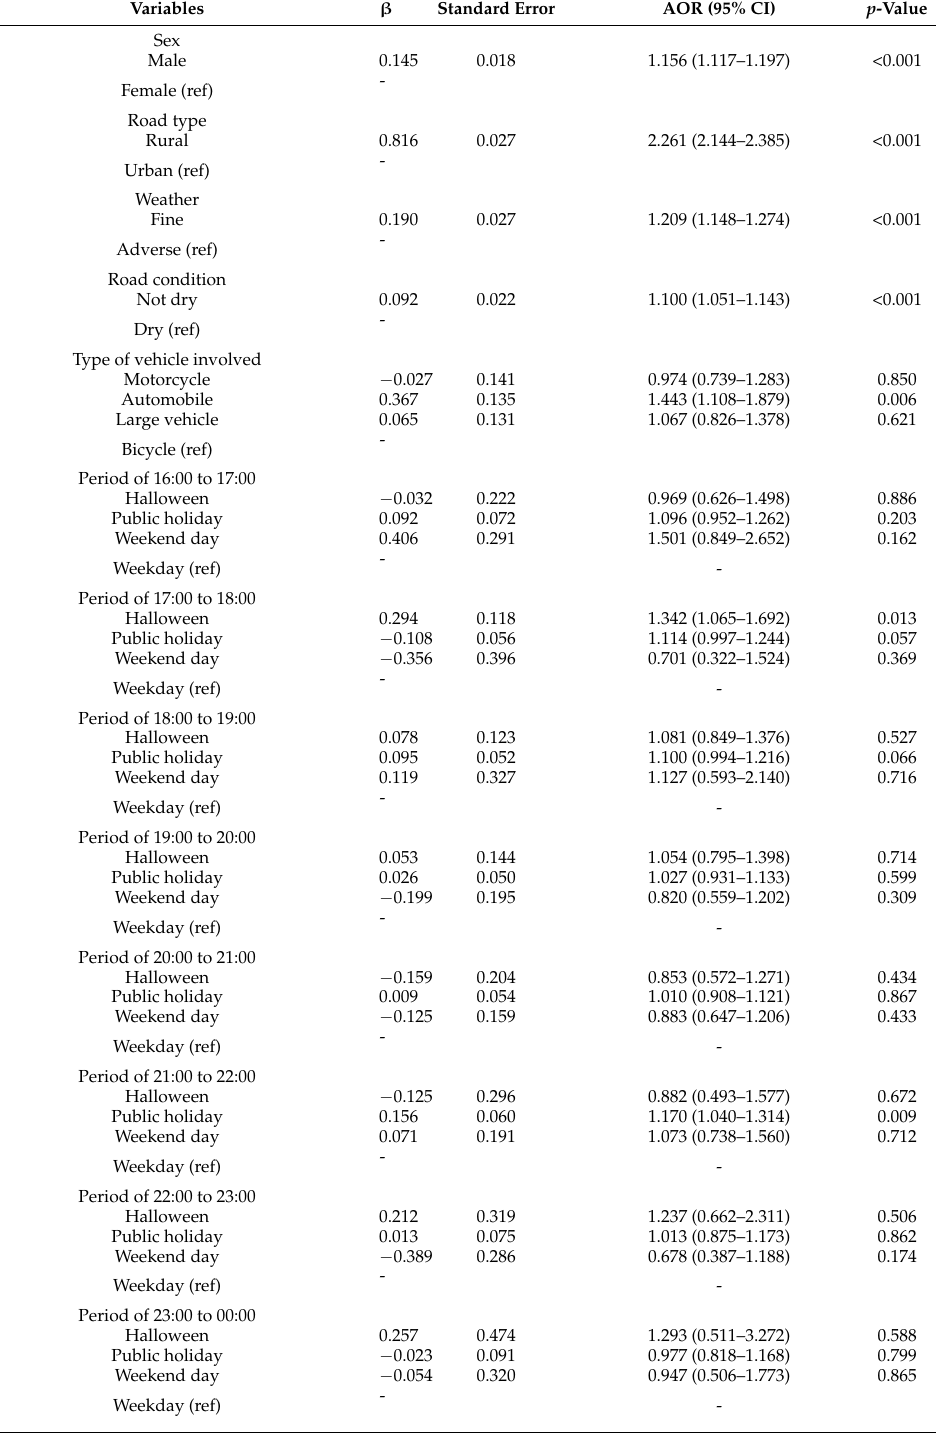
Table 3. Logistic regression results of factors associated with KSI